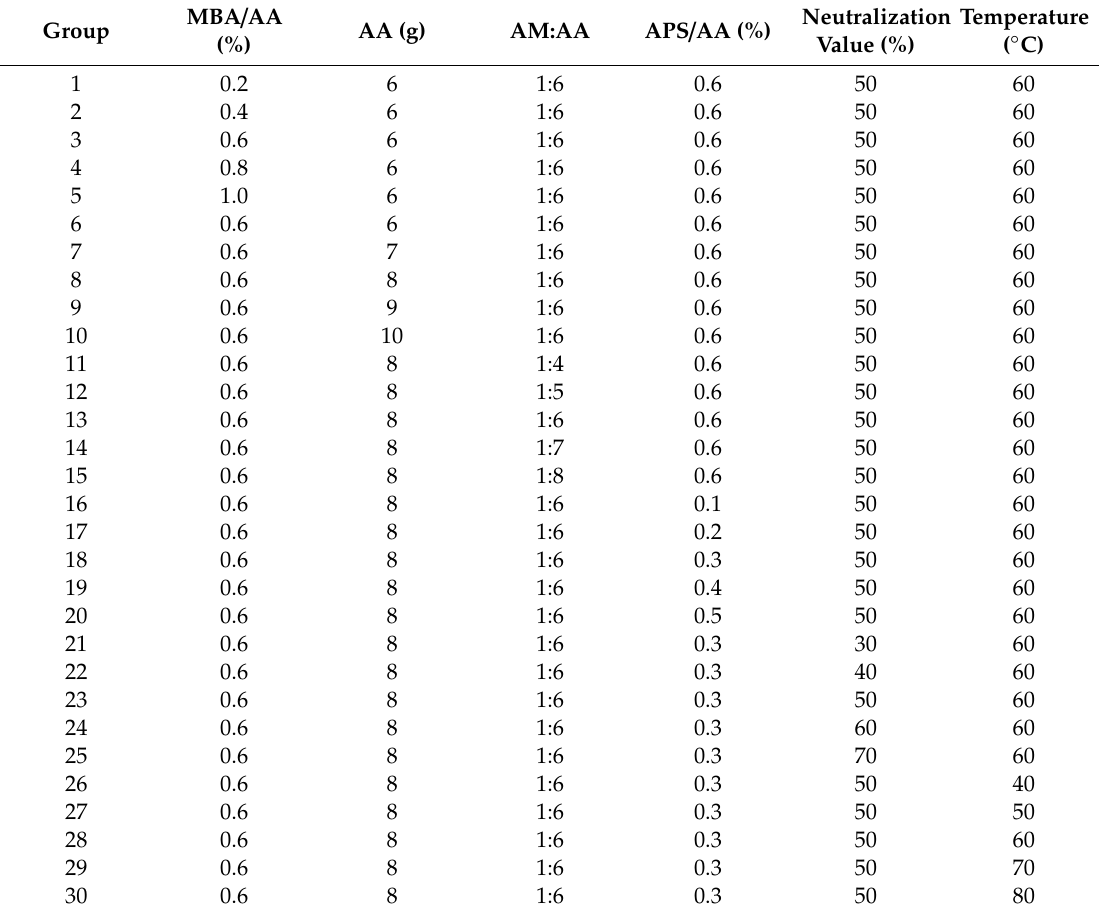
Table 1. The formulation details of SW-AA-AM